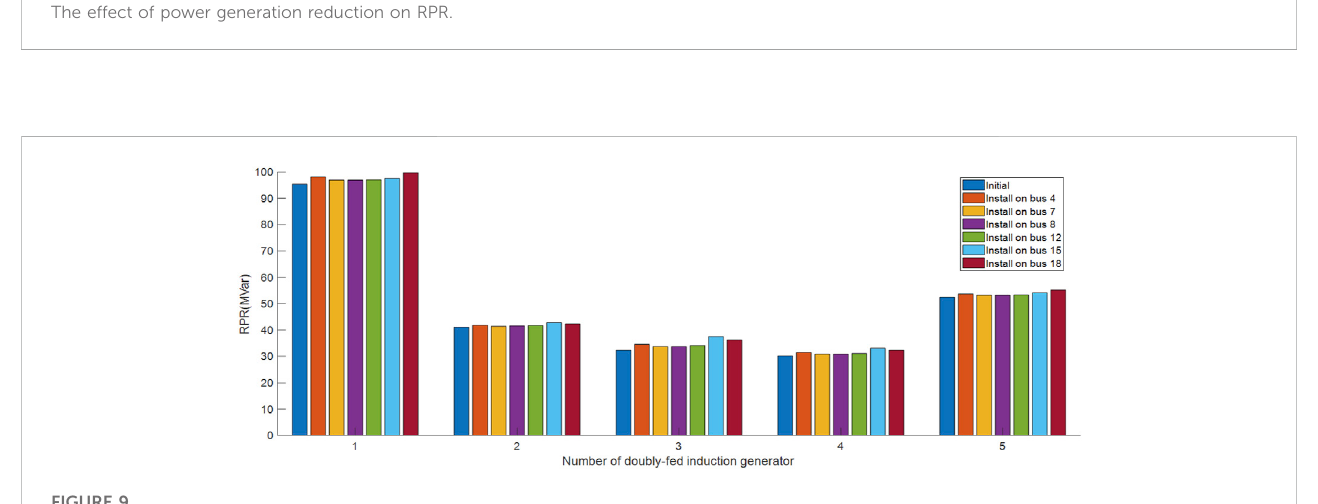
FIGURE 9 The effect of shunt capacitors on RPR.